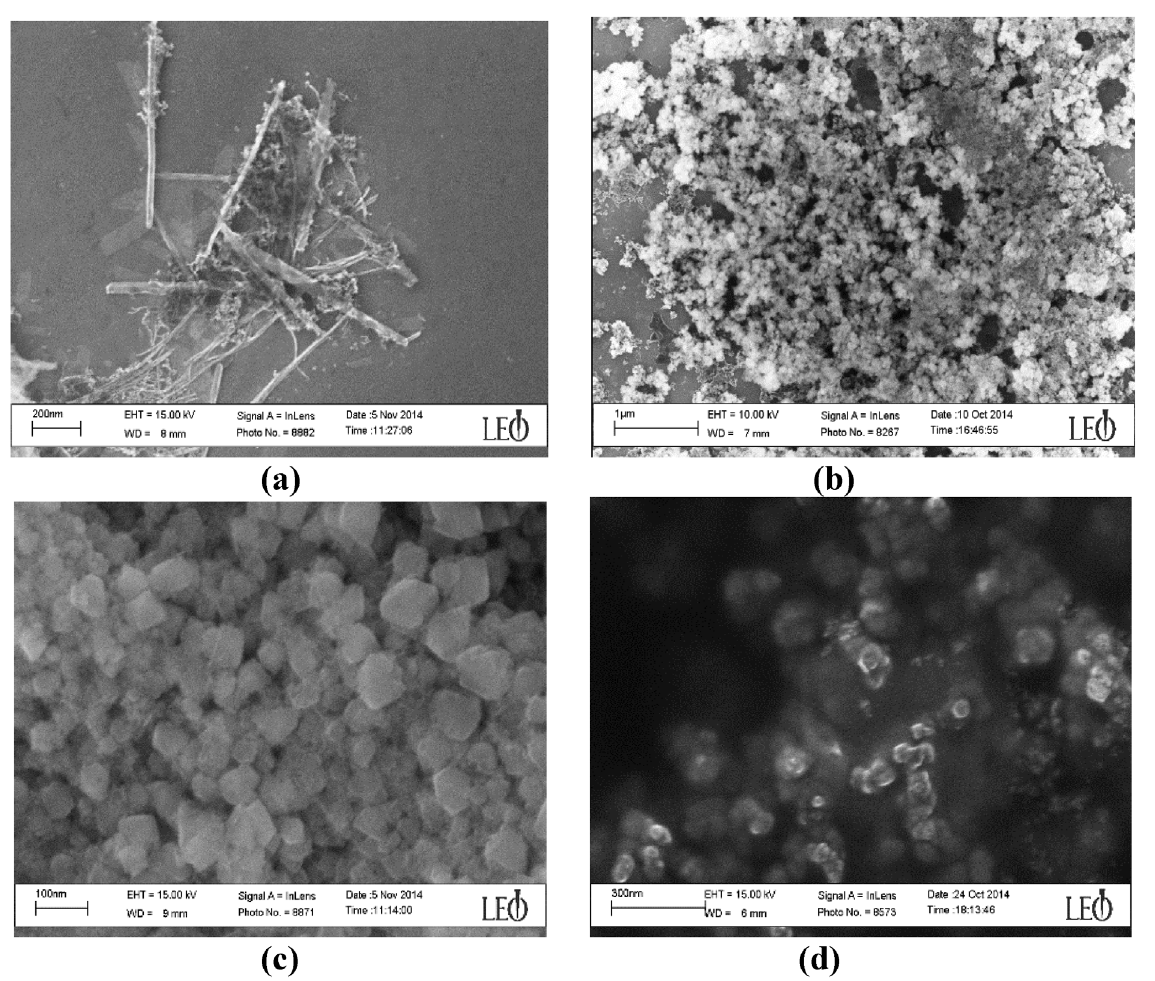
Figure 3: SEM images, (a) aggregation of nanorods at pH=1.5, (b) nanospheres at pH=10, (c) at pH=13. (d) at